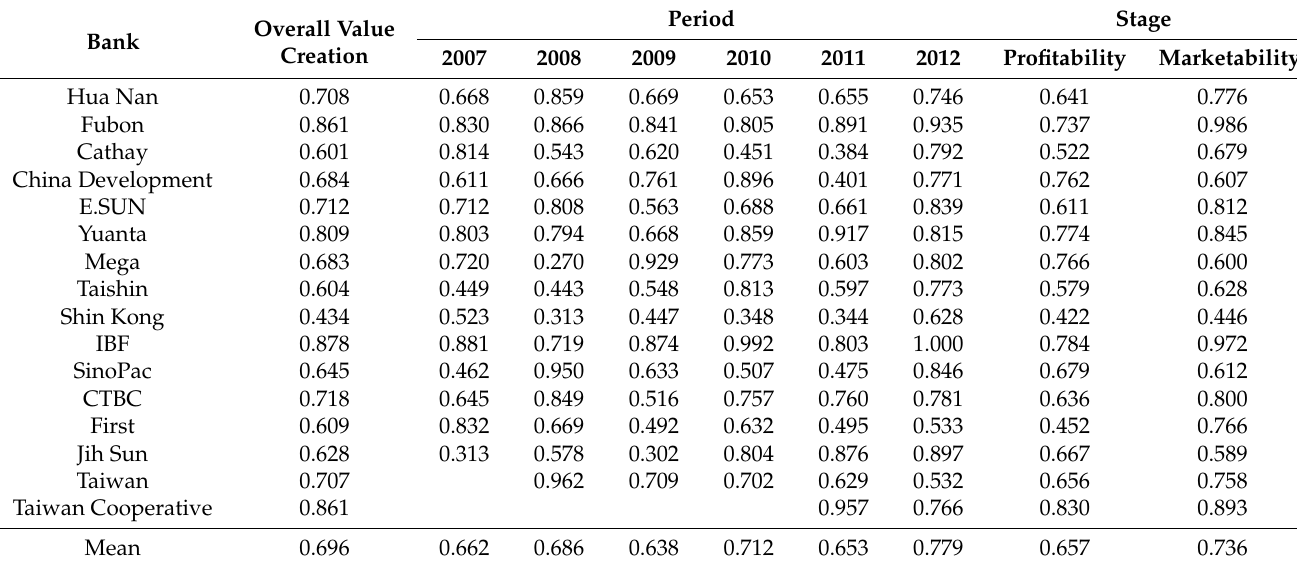
Table 7. Overall value creation, stage, and period performance in Model